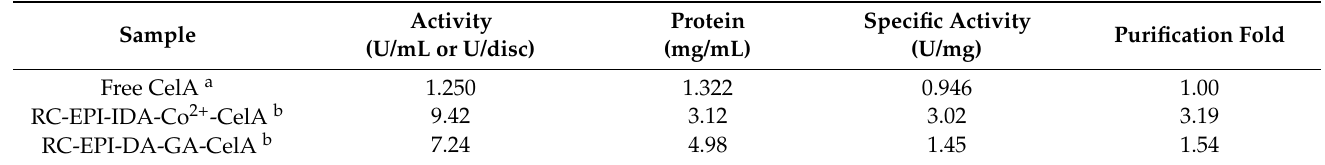
Table 1. Activity and purification effect of free and immobilized